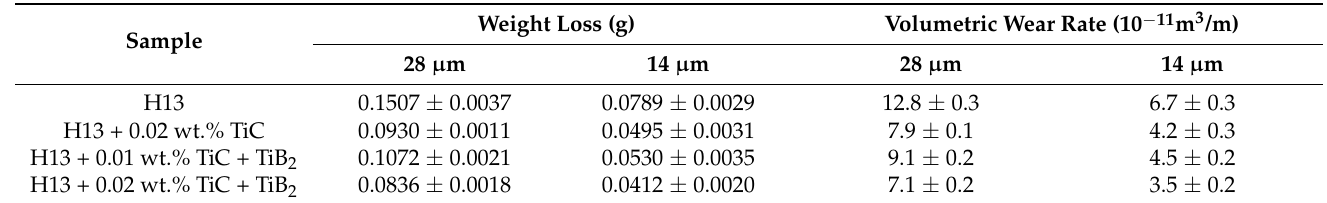
Table 5. Volumetric wear rate of H13 steels without and with nanoparticles at different sandpaper abrasive particle